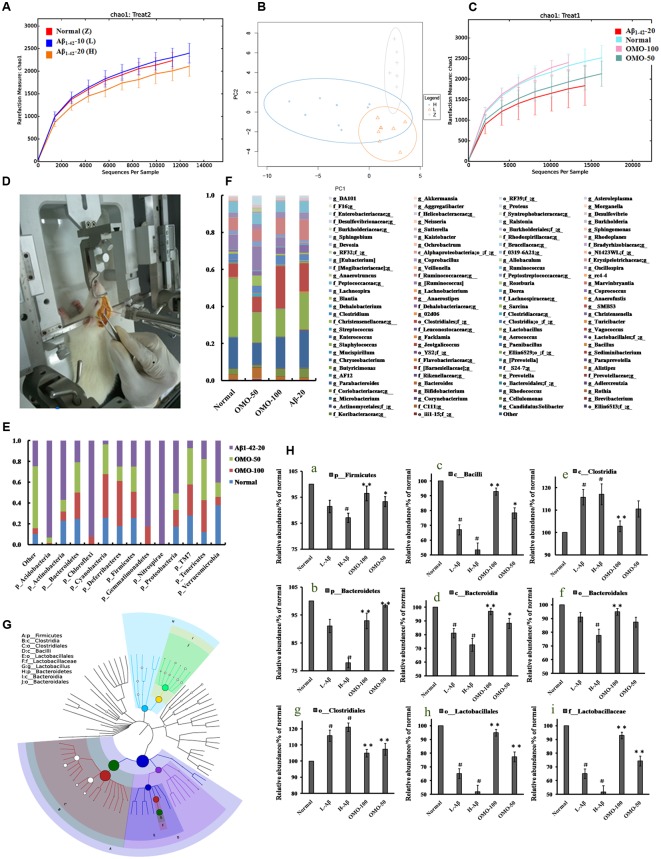
Effects of OMO on gut microbiota in Aβ1-42-induced deficient rats. (A) Rarefaction curve and (B) PCA results of different concentrations of Aβ1-42-induced groups, H (20 μg of Aβ1-42), L (20 μg of Aβ1-42), Z (normal rats with vehicle). (C) Rarefaction curve. (D) Operation schematic diagram. (E) Classification and abundance of cecal contents at the phylum level. (F) Classification and abundance of cecal contents at the genus level. (G) The dominant species classification tree. (H) The relative abundance of the dominant microorganism. Values are the means of six independent experiments.